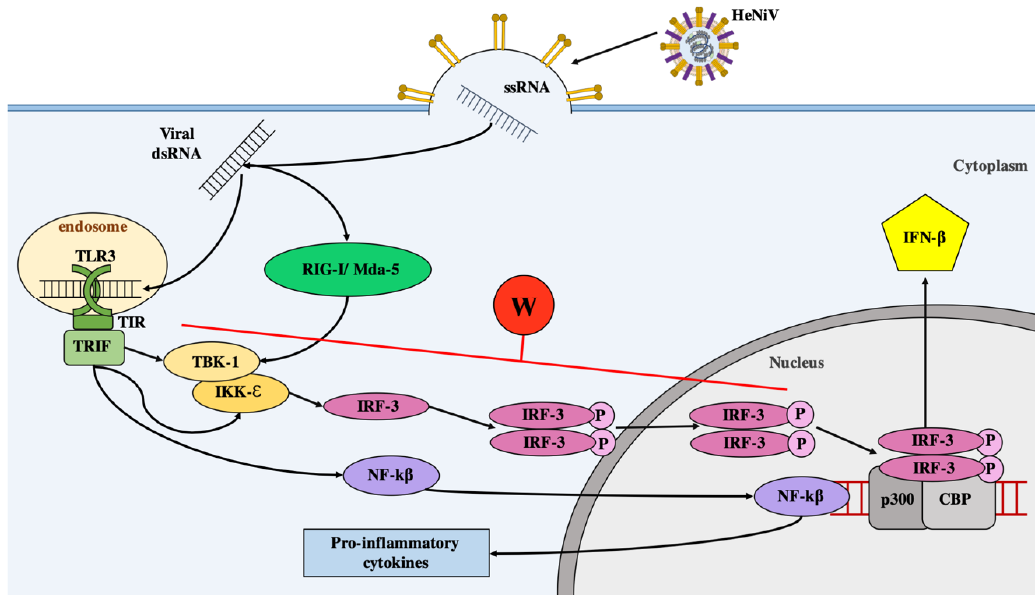
Figure 3. Type I IFN synthesis pathway and production of pro-inflammatory cytokines. Virus-responsive induction of the IFN- β promoter is directed by cytoplasmic helicases RIG-I and MDA5 [74]. Intracellular RNA pathogen-associated molecular patterns (PAMPs; e.g., dsRNA) are recognized by cellular pattern recognition receptors (PRRs; e.g., RIG-I, MDA5, TLR3), triggering antiviral signalling cascades. Activation of two signalling kinases TBK-1 and IKK- ε results in phosphorylation and activation of latent IRF-3 transcription factor that is subsequently translocated to the nucleus upon dimerization [67,68]. IRF-3 binds to p300 and CBP to form the DRAF1 transcription complex for IFN- β production. Cytoplasmic V protein is known to inhibit TBK-1 driven activation of IRF-3, whereas W protein successfully inhibits both TBK-1 and IKK- ε driven activation of IRF-3, with significant e ff ects on TIR-domain-containing adapter-inducing interferon β (TRIF)-mediated activation [29] .